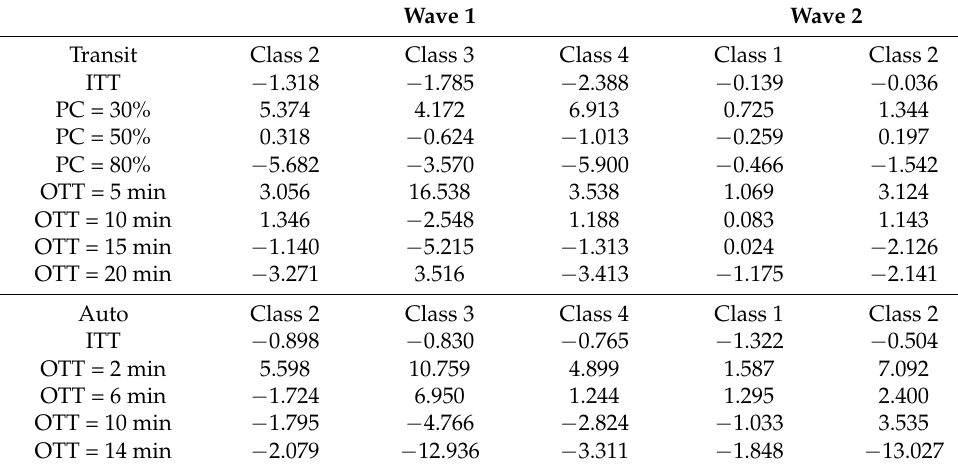
Table 7. Willingness to pay for each of the